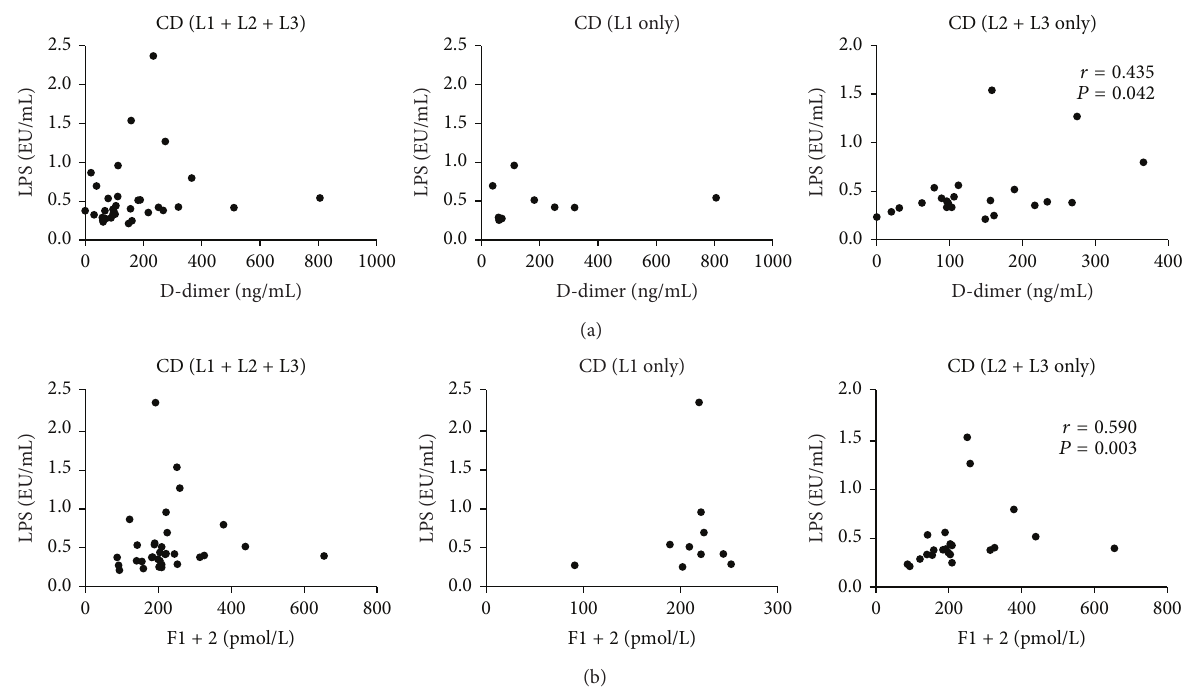
Figure 6: Circulating LPS correlates with markers of activated coagulation in CD patients with colonic involvement. Concentrations of LPS and levels of D-Dimer and prothrombin fragment F 1 + 2 were measured in the sera and plasma, respectively, of CD patients. (a) Correlation between D-Dimer plasma levels and serum LPS in all CD patients (left panel), CD patients with exclusive ileal involvement (L1 according to Montreal classification) (central panel), and CD patients with colonic involvement (L2 + L3 according to Montreal classification). (b) Correlation between prothrombin fragment F 1 + 2 and circulating LPS in all CD patients (left panel), CD patients with exclusive ileal involvement (L1 according to Montreal classification) (central panel), and CD patients with colonic involvement (L2 + L3 according to Montreal classification). Statistical analysis was performed by means of Spearman Correlation Test. 𝑃 < 0.05 was considered statistically